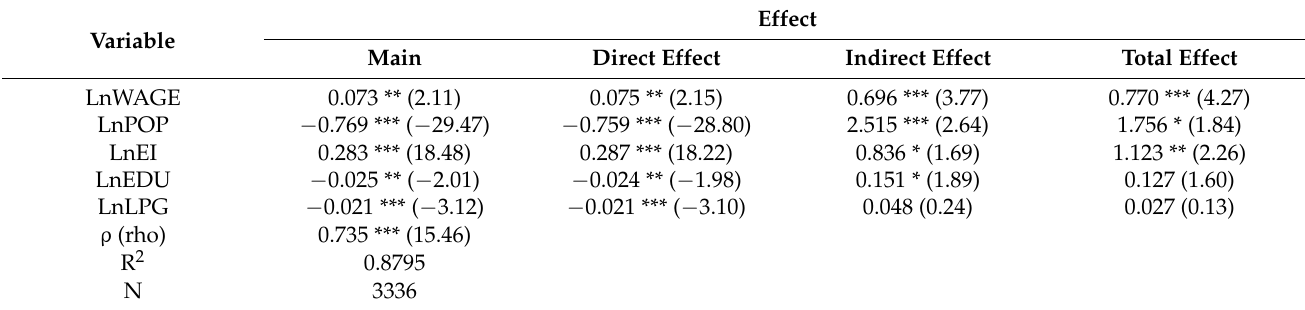
Table 11. Regression results of SDM under the W_distance.